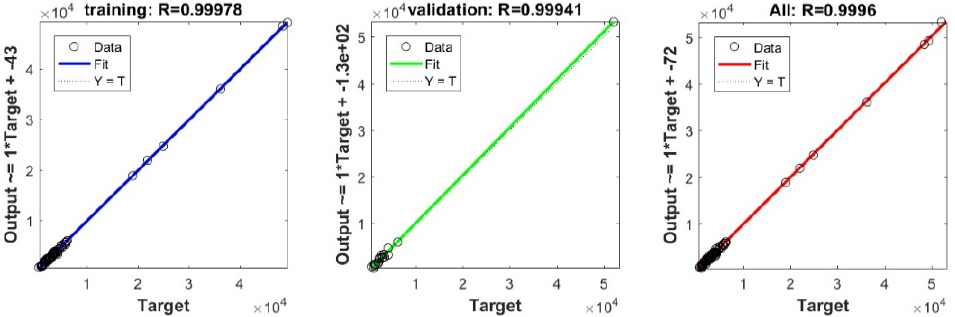
Figure A2. Scatter plots between target and output values by the DNN model.